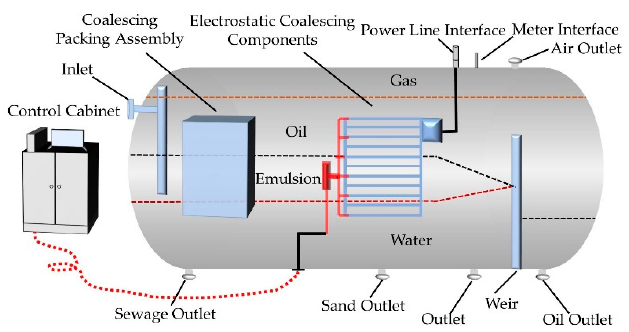
Figure 3. Internal overall layout of the electric-field-enhanced three-phase separator. Table 1. The process parameters of the pilot test platform. Parameter Value Parameter Value Design flowrate 10 m 3 /h